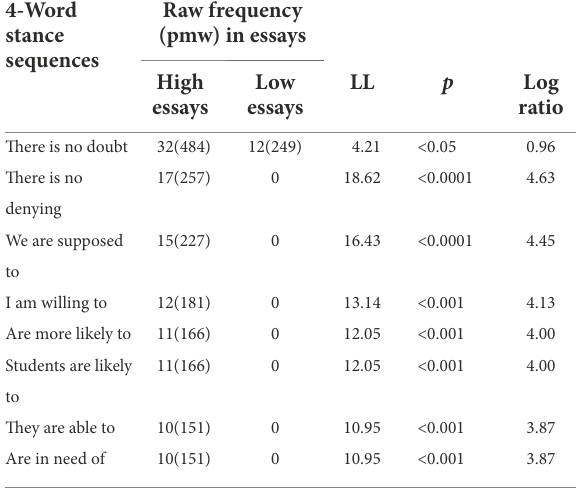
TABLE 5 4-Word stance sequences appearing more in high-rated